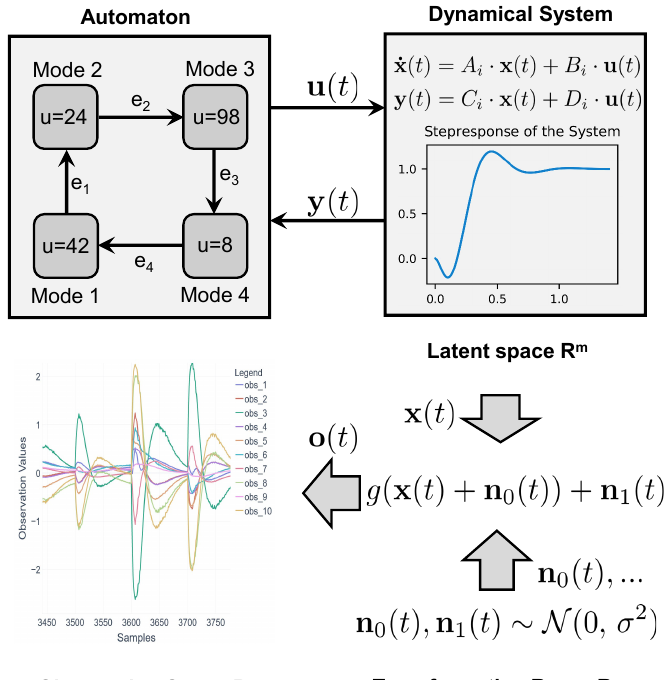
Figure 1. General concept of the CPS data generation model: An automaton (e.g., containing four modes M i ) interacts with a dynamical system. Its control values u ( t ) force the dynamical system to move its response y ( t ) towards the control values. While performing this movement, the internal states x ( t ) ∈ R m , that define the order of the dynamical system change their values according to Equation (1). As the automaton cyclically evaluates whether e i from Equation (2) is true, mode changes are triggered automatically. The resulting trajectory of x ( t ) is then transformed trough the nonlinear mapping function g ( · ) (Equation (3)) into the observation space o ( t ) ∈ R n